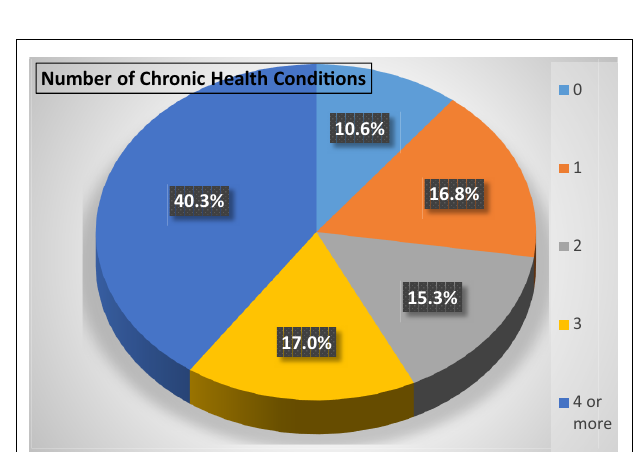
FIGURE 2 | Number of chronic health conditions in 983 adults with intellectual and developmental disabilities